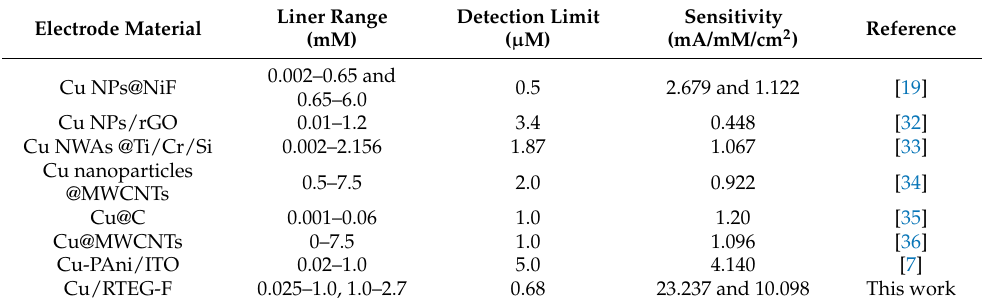
Table 1. Comparison with other copper based non enzyme glucose sensors.